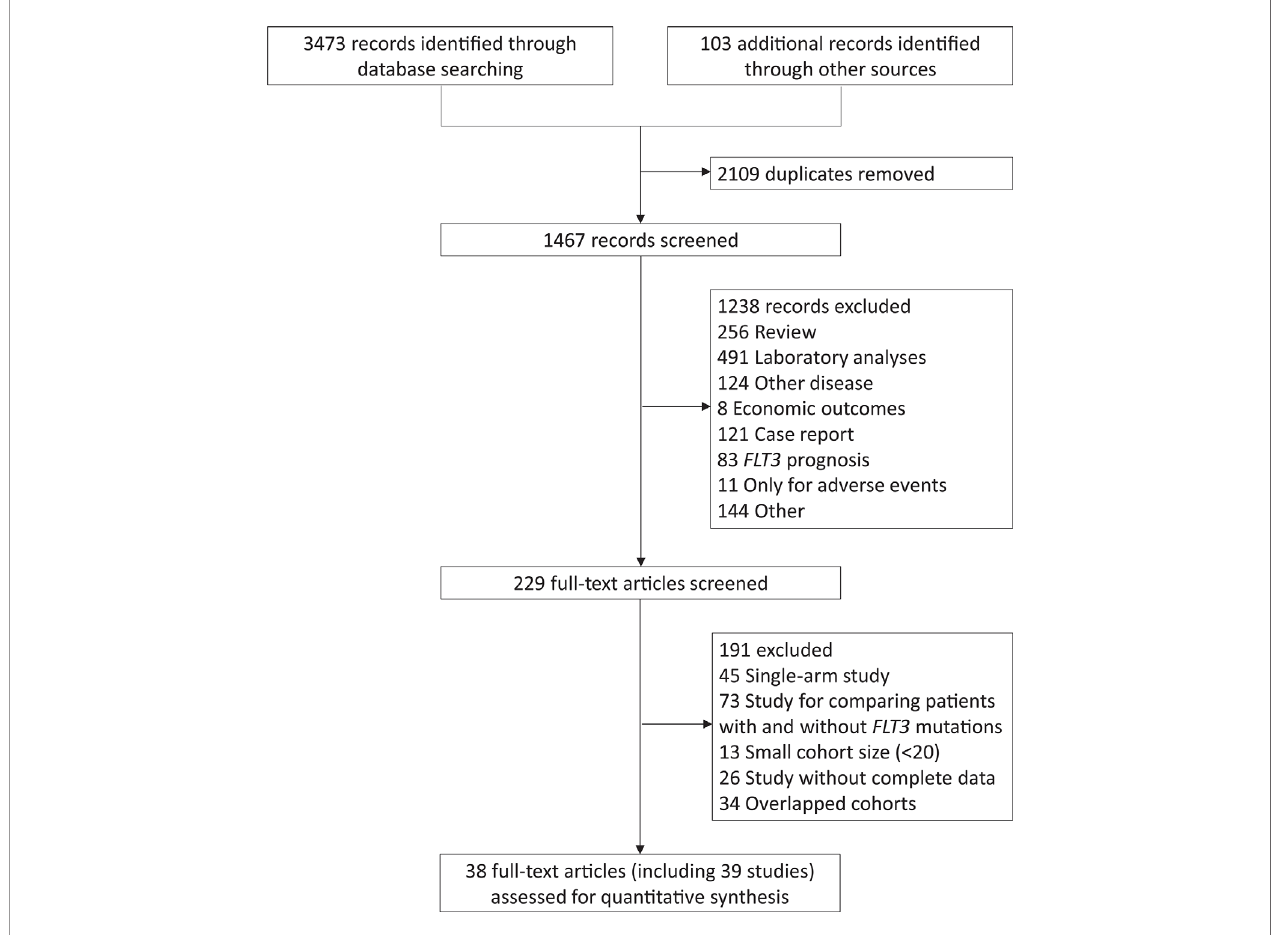
FIGURE 1 | Flow diagram of the study selection. FLT3, FMS-like tyrosine kinase